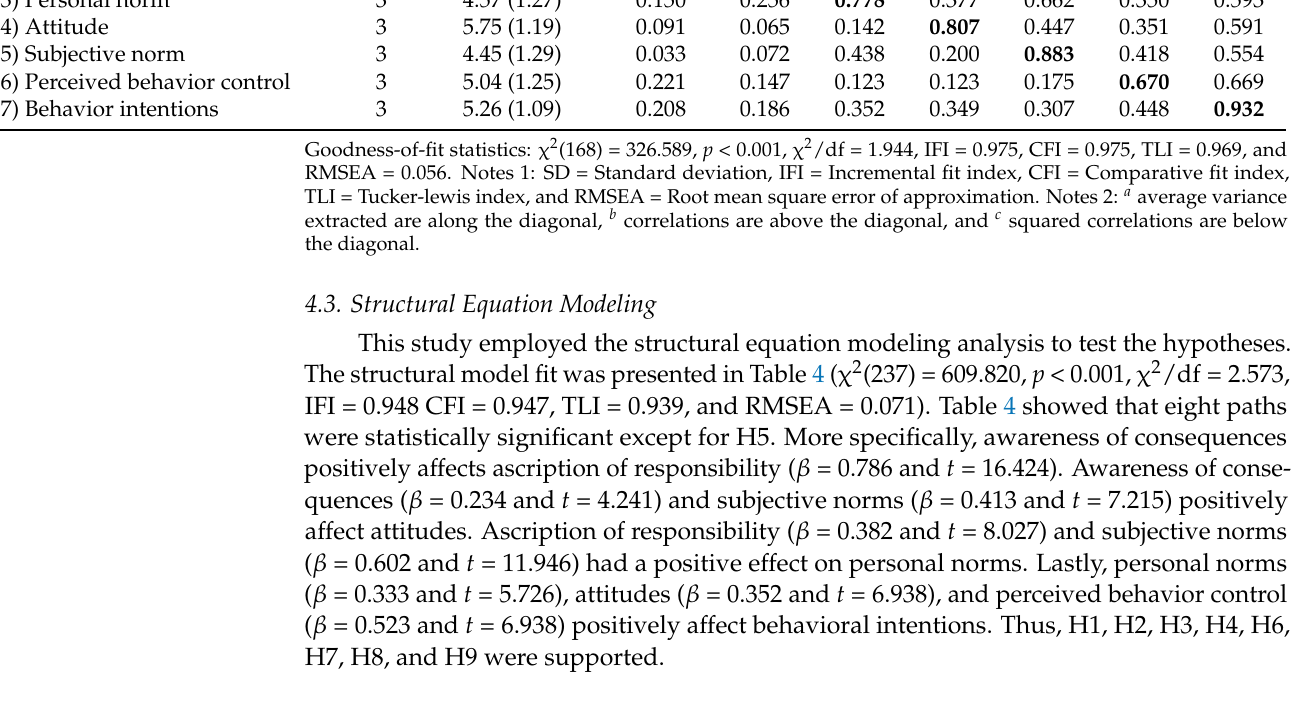
Table 4. Standardized parameter estimates for the structural